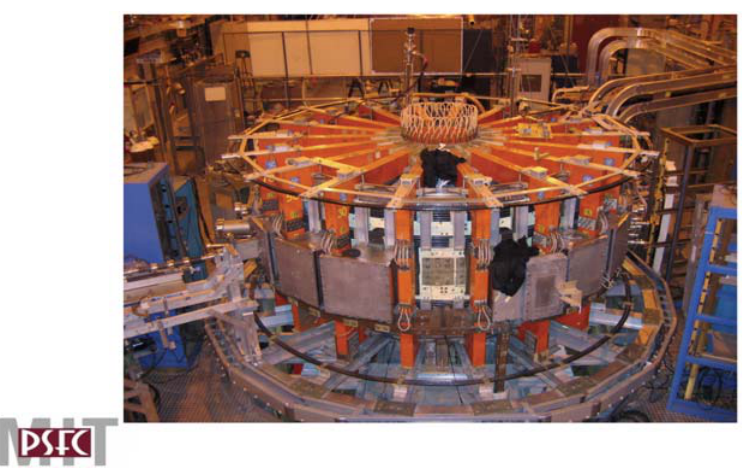
Figure 14. The MIT Versatile Toroidal Facility